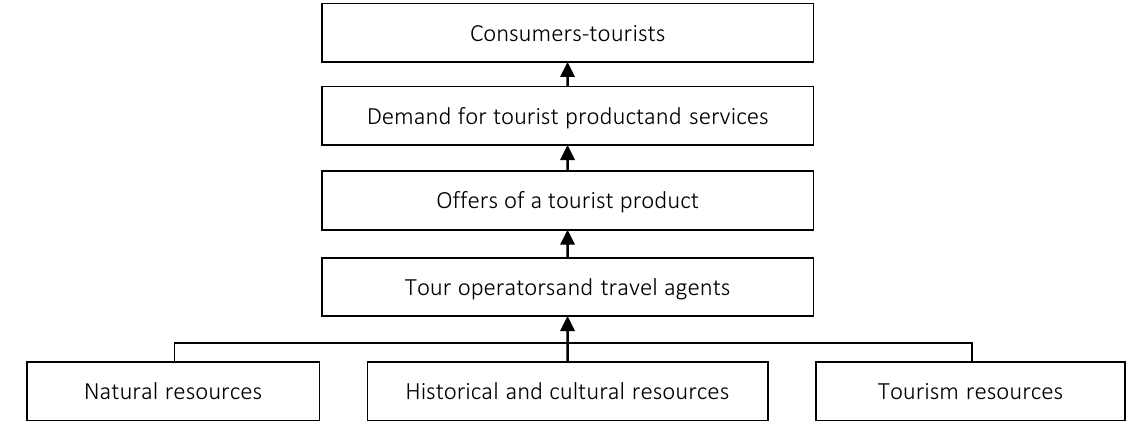
Figure 1. Mechanism of the tourism industry Table 1. Generalized result of the contribution of tourism to the formation of GDP and employment in some countries